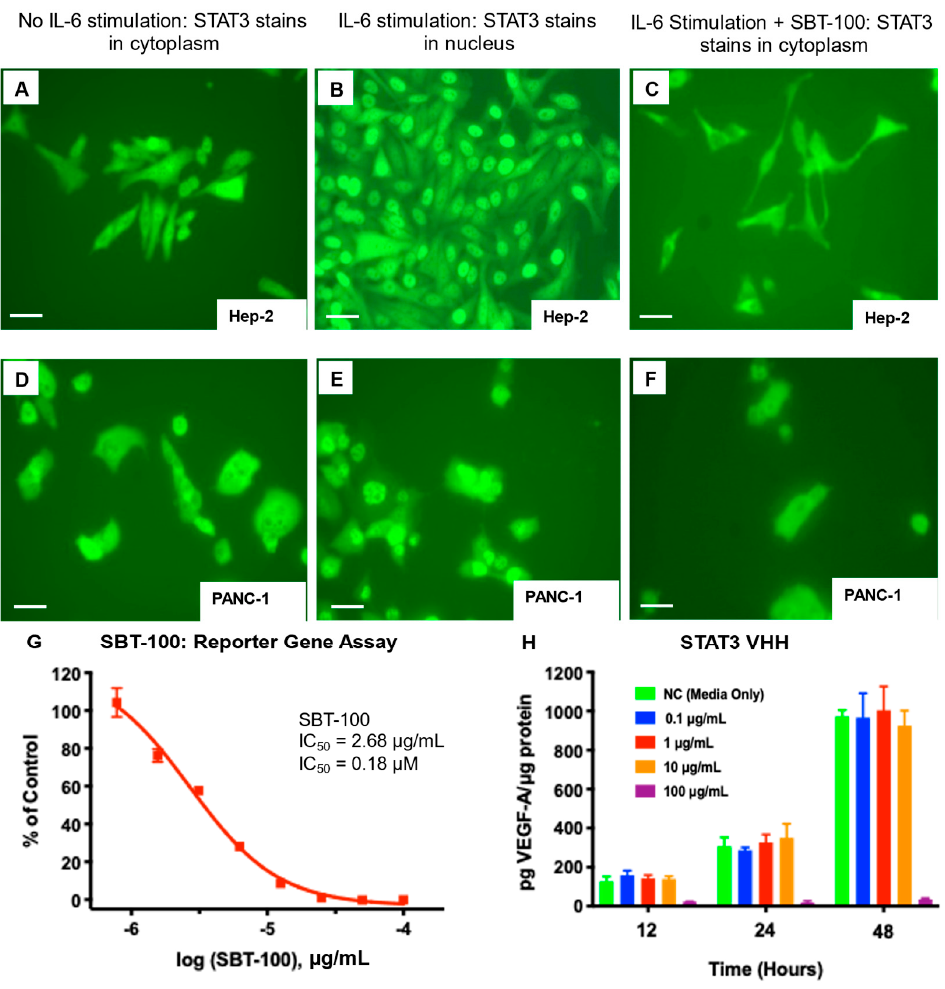
Figure 5. SBT-100 inhibits IL-6-induced nuclear translocation of pSTAT3 and VEGF production in various cell lines. Fluorescent microscopy of phosphorylated STAT3 in Hep-2 cells under normal conditions ( A ), upon IL-6 stimulation ( B ), and with both IL-6 stimulation and SBT-100 treatment ( C ). Fluorescent microscopy of phosphorylated STAT3 in Panc-1 cells under normal conditions ( D ), upon IL-6 stimulation ( E ), and with both IL-6 stimulation and SBT-100 treatment ( F ). The scale bars in the lower-left corner of panels ( A – F ) represent 50 µm. ( G ) STAT3 luciferase reporter assay in HEK 293T cells with SBT-100 treatment after IL-6 stimulation. ( H ) Measurement of VEGF levels by ELISA in retinal epithelial cells stimulated with IL-6 in the presence of increasing concentrations of SBT-100. Values are normalized to the total protein level. At 12, 24, and 48-h time points, SBT-100 at 100 ug/mL gave > 99% suppression of VEGF protein production ( p < 0.0001). The scale bars in the lower-left corner of each panel represent 50 µm.